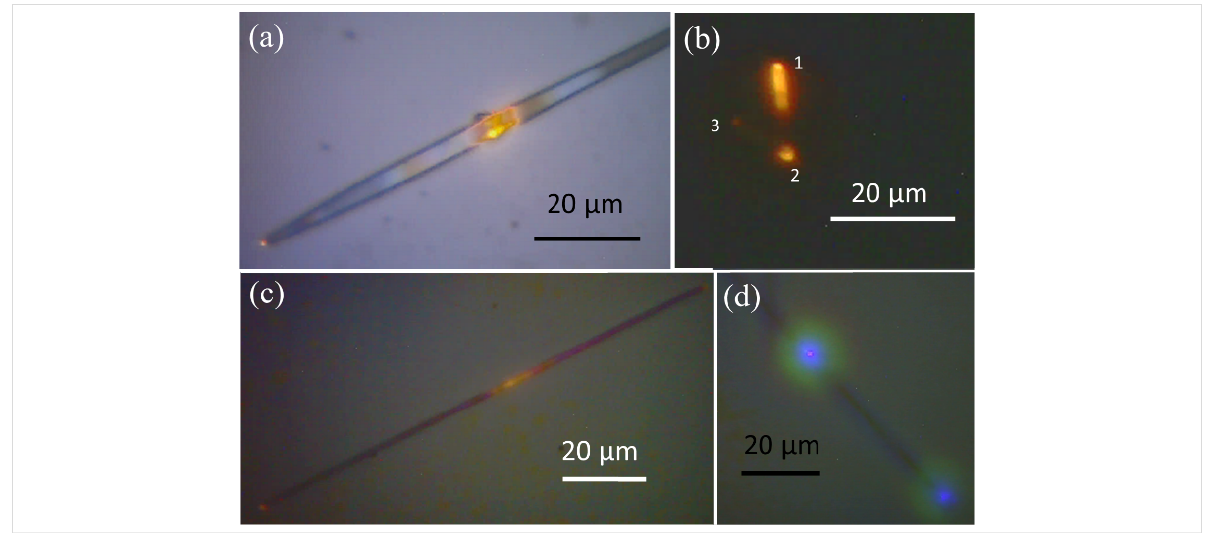
Figure 6: Waveguide nature of the various NBs. (a) Tapered NB, (b) ‘V’-shaped NB, (c) NB of length 120 µm, (d) OTS-functionalized NB.